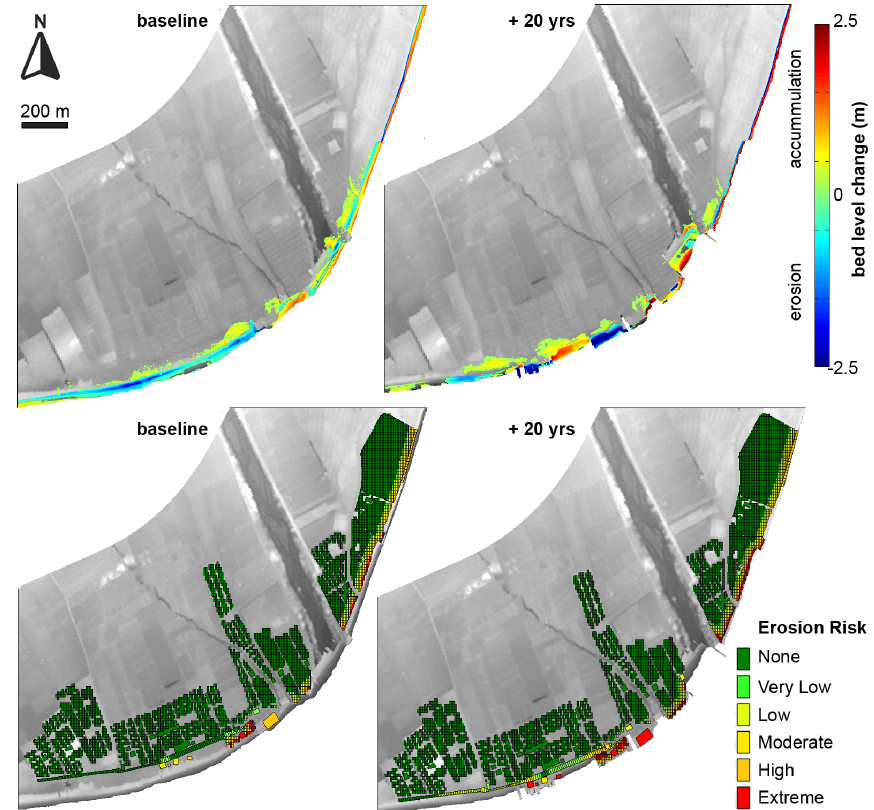
Figure 4. Example of transformation from erosion hazard to risk. Storm event of November 2001, Hs = 5.4m, Tp = 13s, eastern direction, and 96h of event duration. Orthophoto provided by Institud Cartogràgic I Geològic de Catalunay